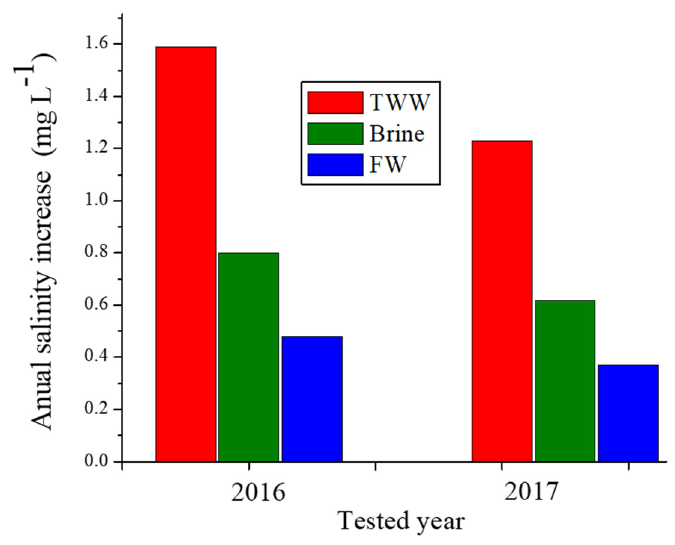
Figure 5. The long-term average of the salinity increase ( ∆ C cl ) of the pumped water from the Yarkon-Taninim aquifer following the treated wastewater (TWW), brine, or fresh water (FW) applications on the total area of the unpaved roads located above the aquifer in the years 2016 and 2017 as examples.